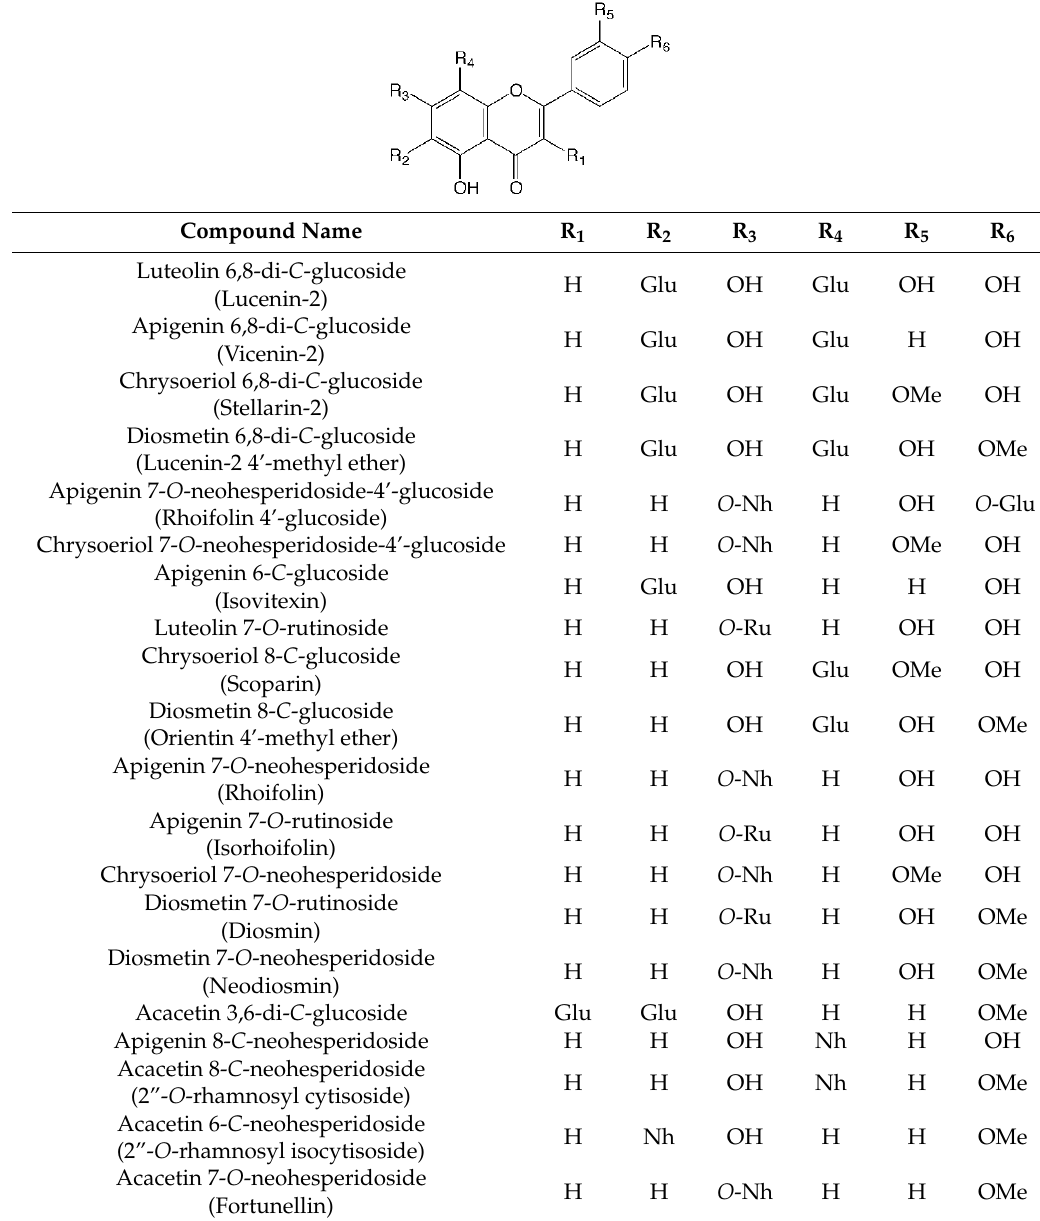
Table 3. Glycosylated flavones occurring in Citrus spp.